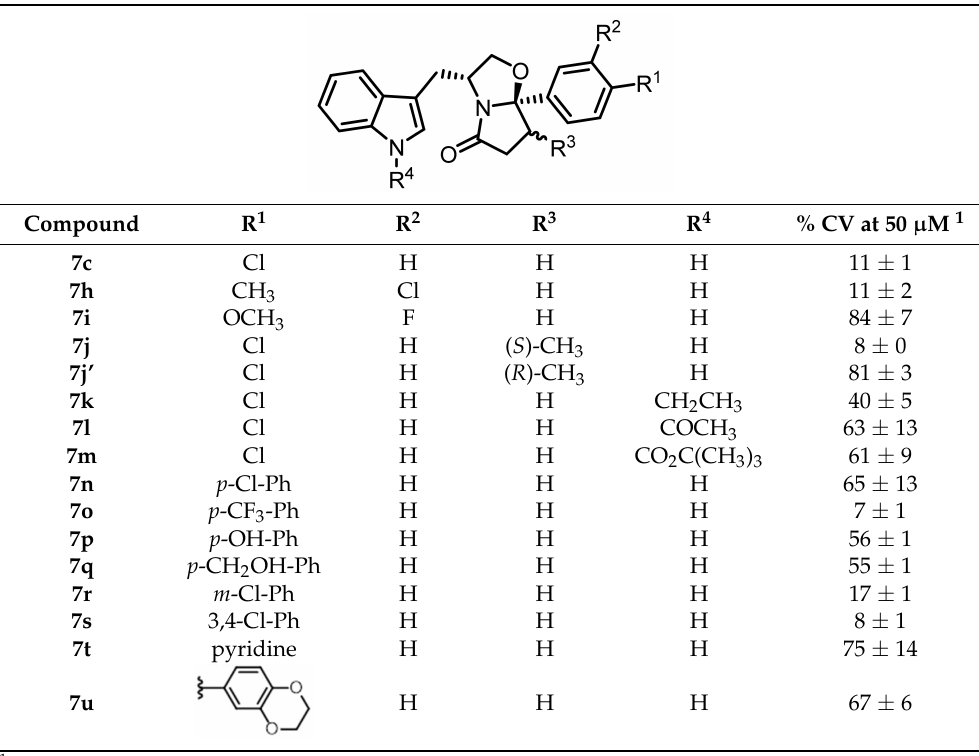
Table 2. Screening of ( R )-tryptophanol-derived oxazolopyrrolidone lactams 7c , 7h – u , and 7j’ in AGS cell